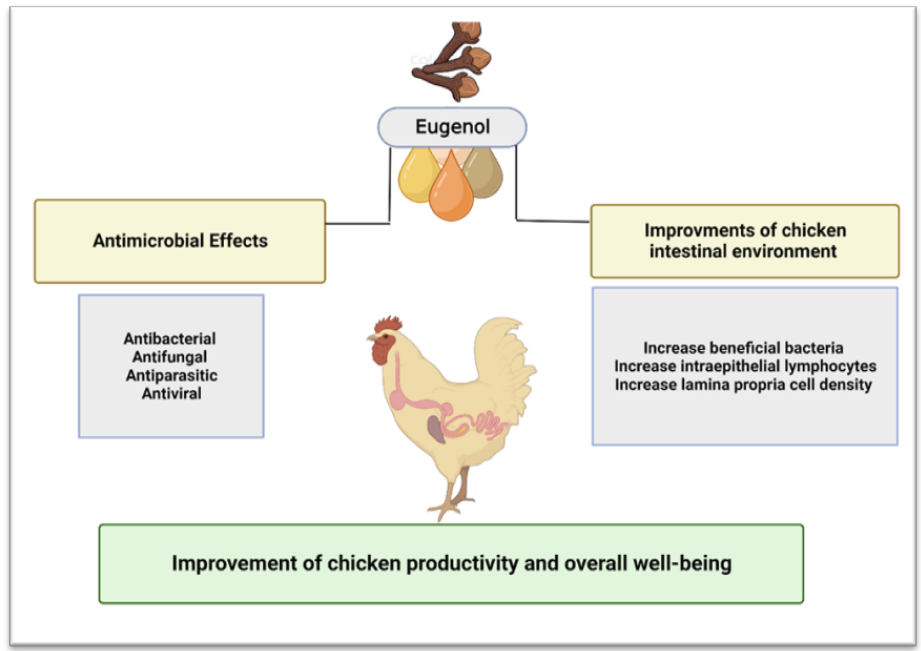
Figure 1. Beneficial effects of eugenol supplementation in chickens. Created with BioRender.com, accessed on 5 December